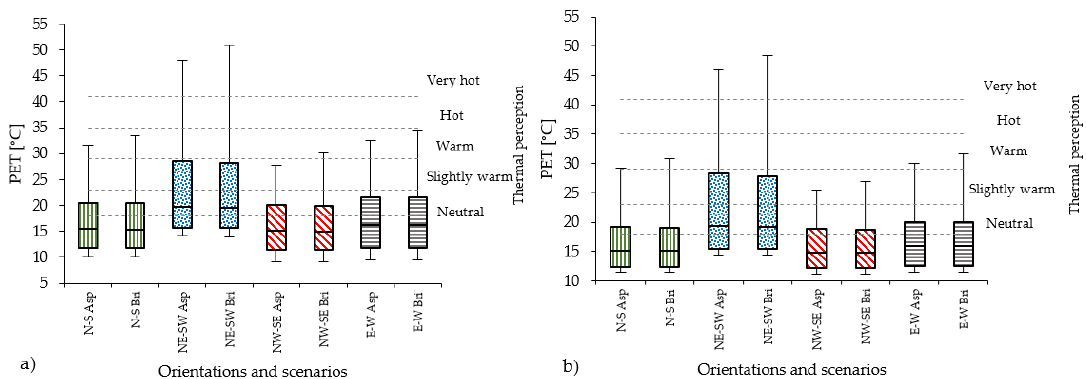
Figure 8. PET values measured in all 14 receptors for scenarios with asphalt (Asp) and brick red stones (Bri) pavement for compact mid-rise ( a ) and open-set high-rise ( b ) urban areas in all orientations. Table 12. Peak values of PET, T s , T mrt , T a , RH and W s for all orientations with asphalt and red brick stones in compact mid-rise and open set high-rise urban canyons.